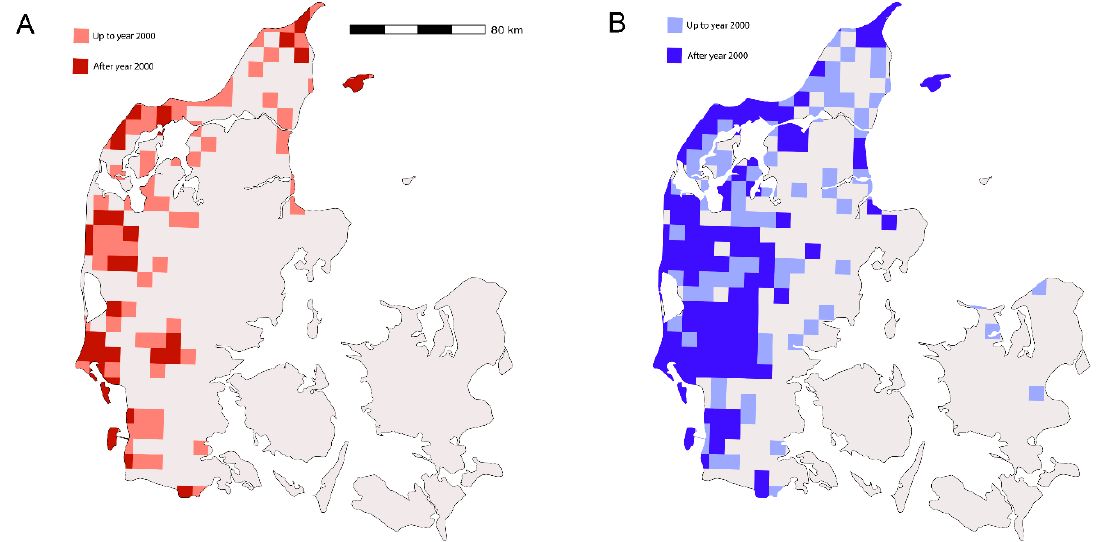
Figure 1. Spatiotemporal distribution maps for P. alcon ( A ), and G. pneumonanthe ( B ) in Denmark, shown as 10 × 10 UTM grid squares in which each species has been recorded (see Supplementary Methods